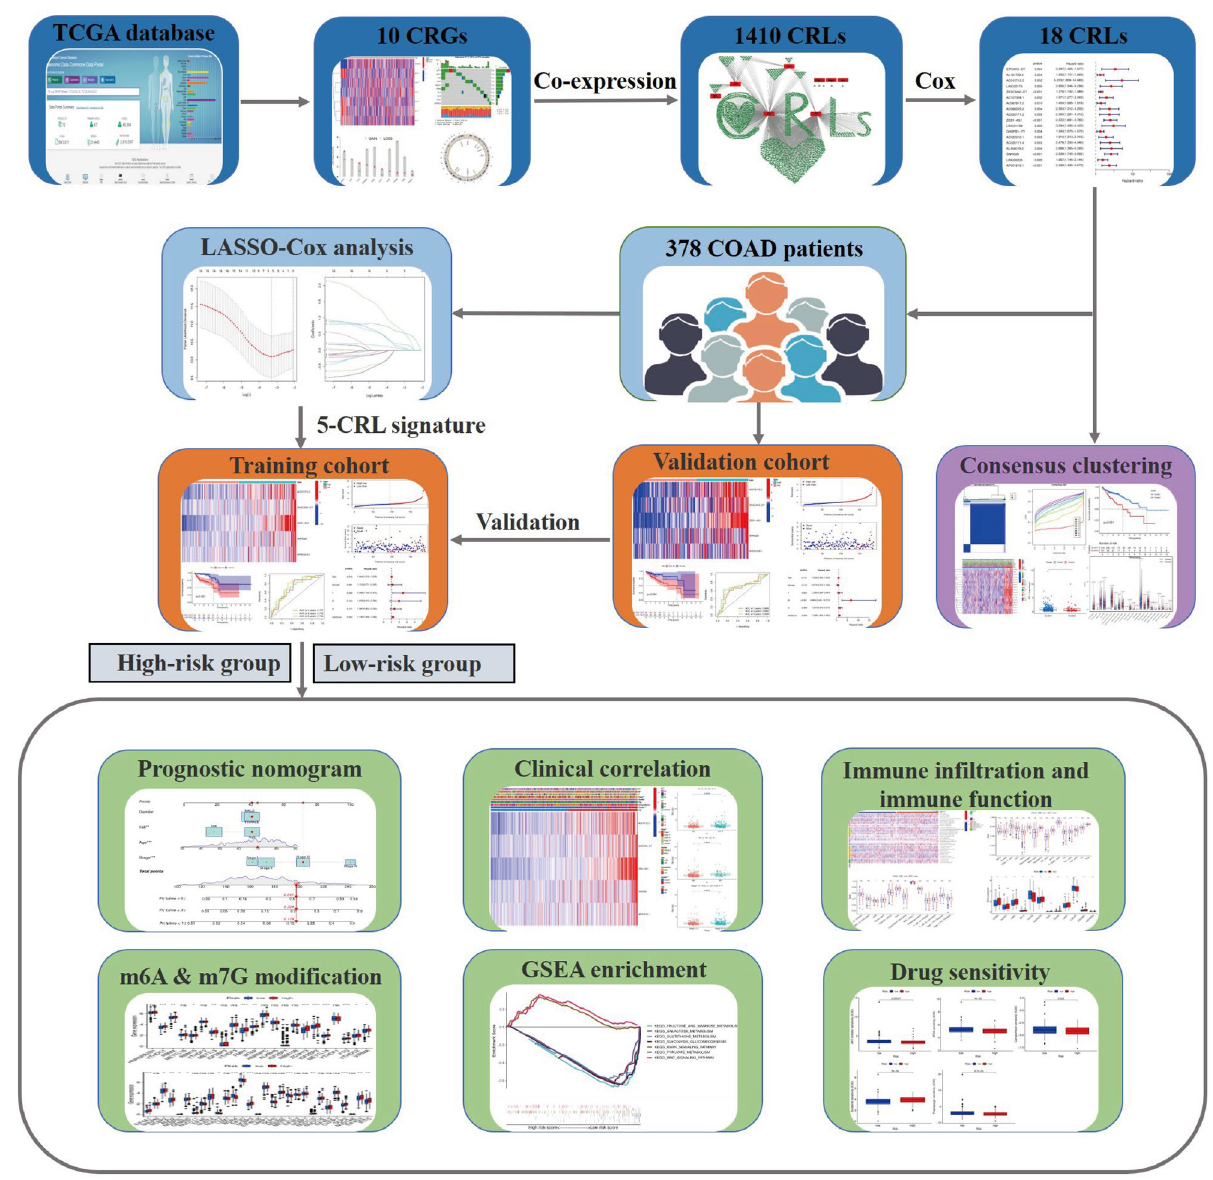
Figure 1. The workflow chart in this